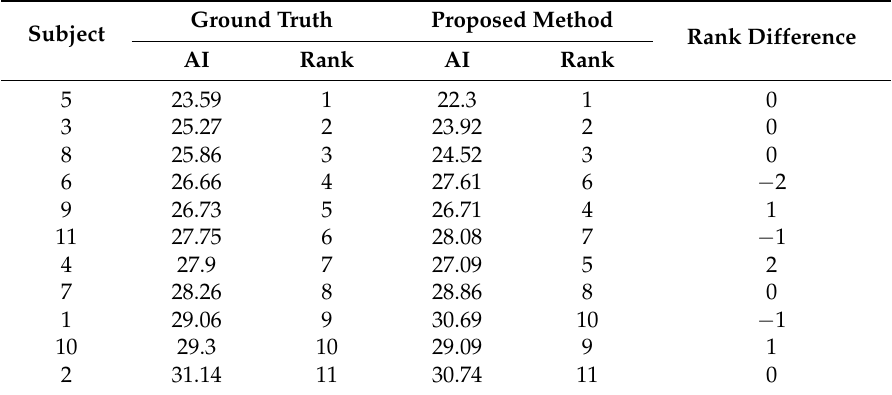
Table 2. Individual subject rankings based on AI.